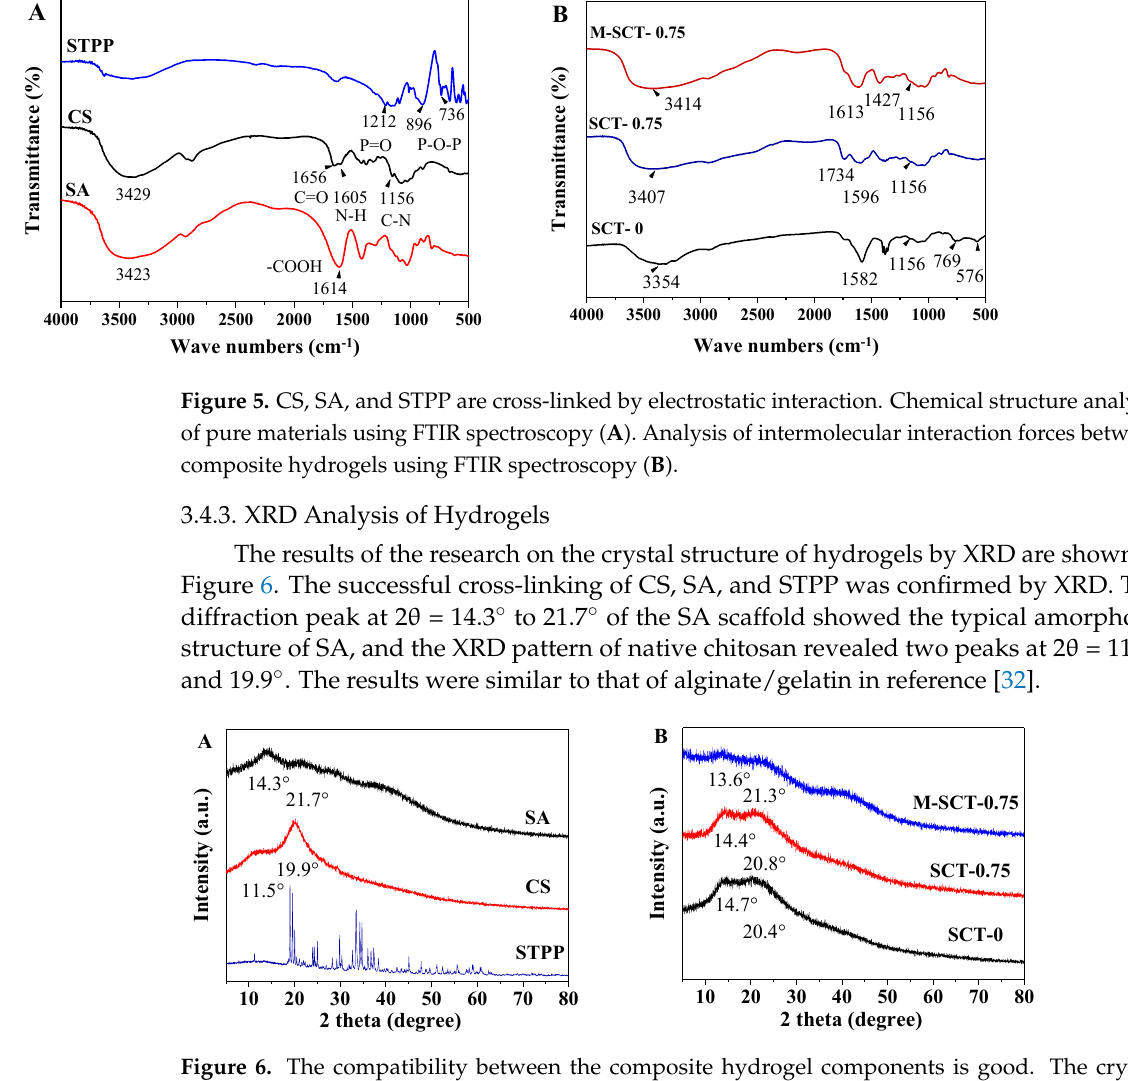
Figure 6. The compatibility between the composite hydrogel components is good. The crystal structures of the lyophilized pure materials’ samples ( A ) and composite hydrogel samples ( B ) were analyzed using XRD.